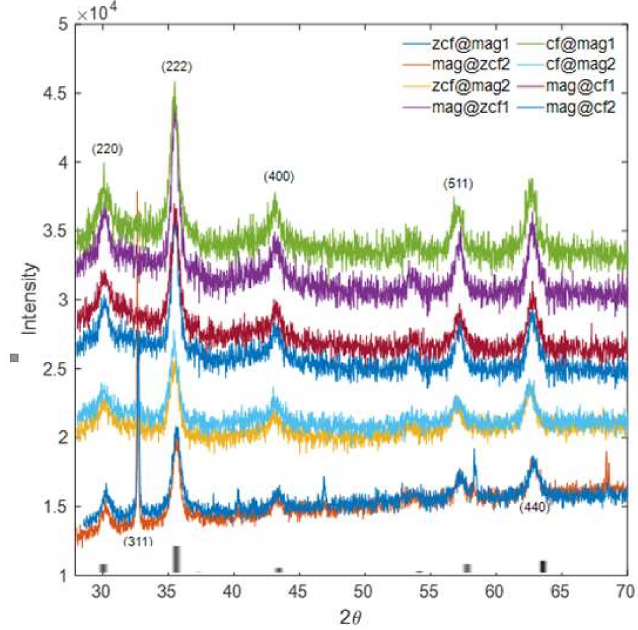
Figure 1. X-ray di ff raction (XRD) spectra of various core-shell